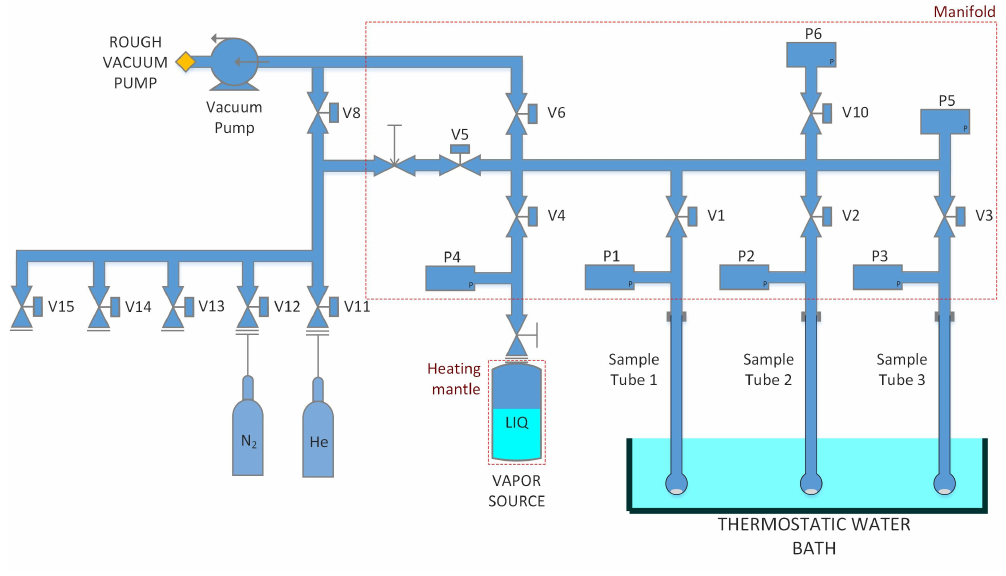
Figure 2. Schematic picture of the experimental